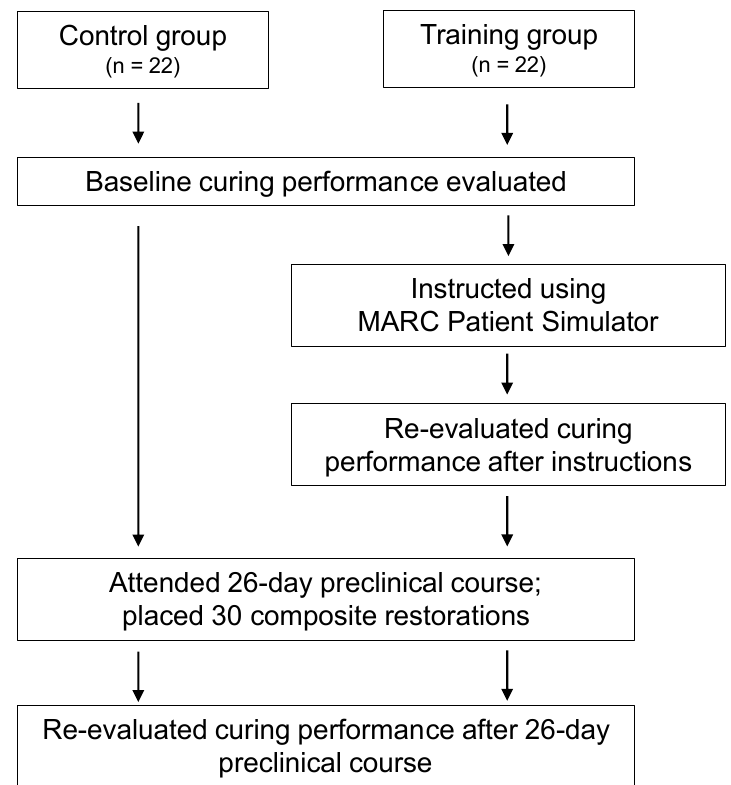
Figure 1. Schematic representation of the study protocol.